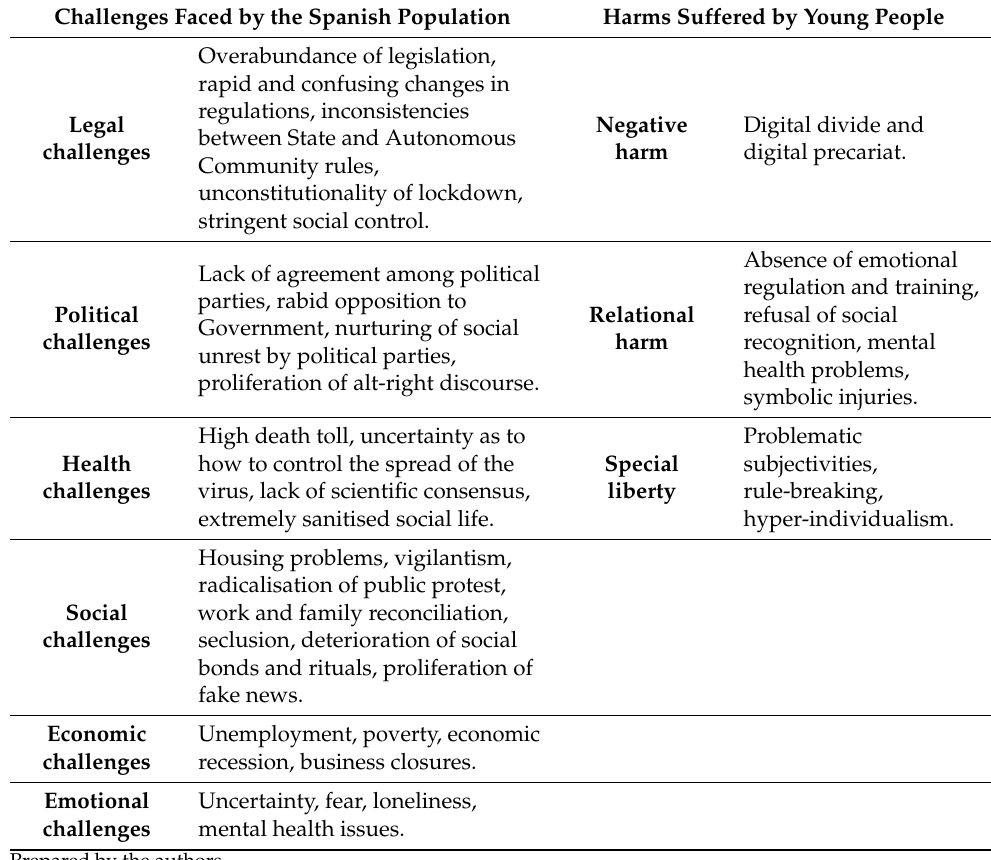
Negative Digital divide and harm digital